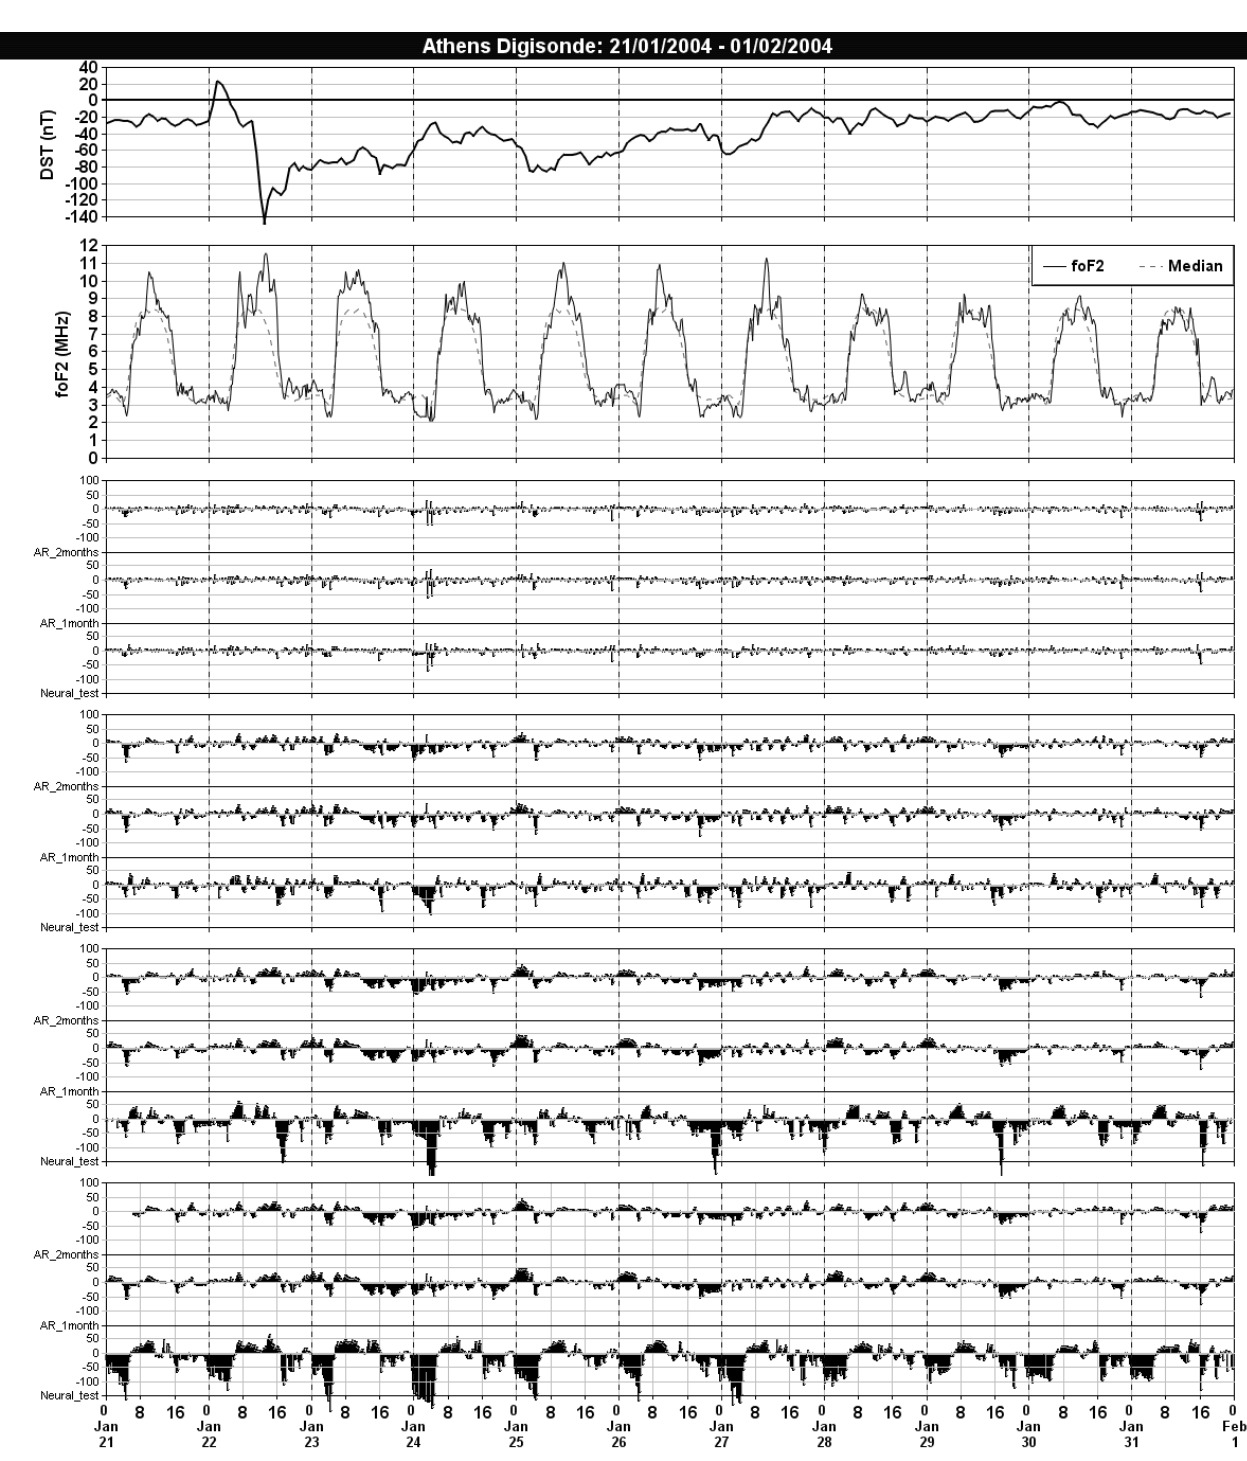
Fig. 3. The same as Fig. 2 for the storm interval 21–31 January